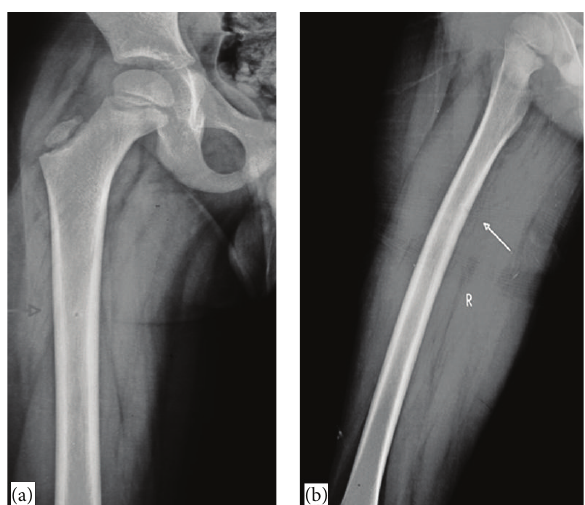
Figure 1: AP (a) and lateral (b) radiograph of the right femur show a well-defined linear radiolucent defect along the medial cortex of femur in its upper and middle third junction with sclerotic rim.